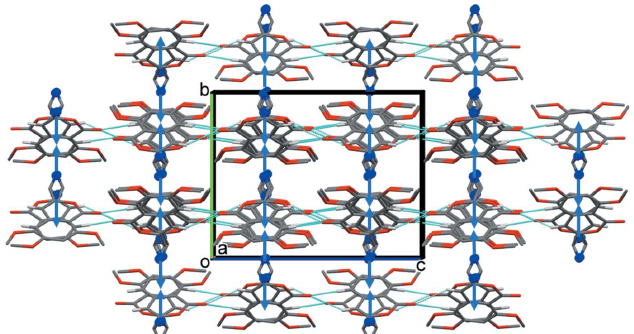
Figure 4 A view along the a axis of the crystal packing of compound I . The hydrogen bonds (Table 1) are shown as dashed lines and the C—H (cid:2)(cid:2)(cid:2) (cid:2) interactions as blue arrows. For clarity, only the H atoms (grey sticks and blue balls) involved in these interactions have been